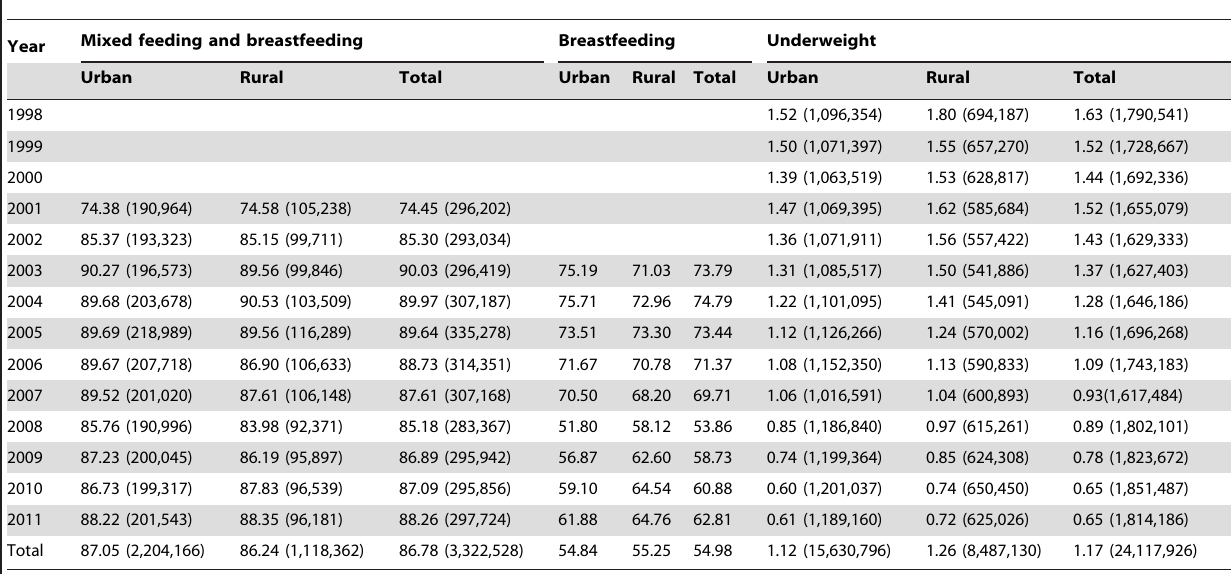
Figure 2. Indicators of child health and service utilization. (a) Number of newborns; (b) Hospital delivery rate; (c) Low birth weight rate; (d) Postnatal visit rates.